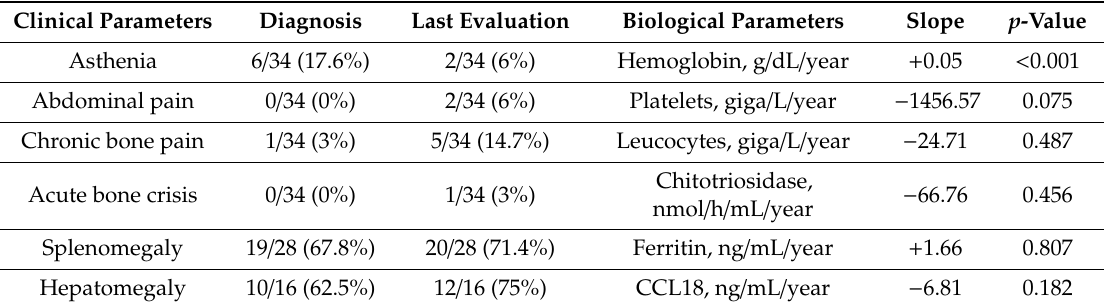
Table 2. Changes in clinical and biological parameters between diagnosis and last